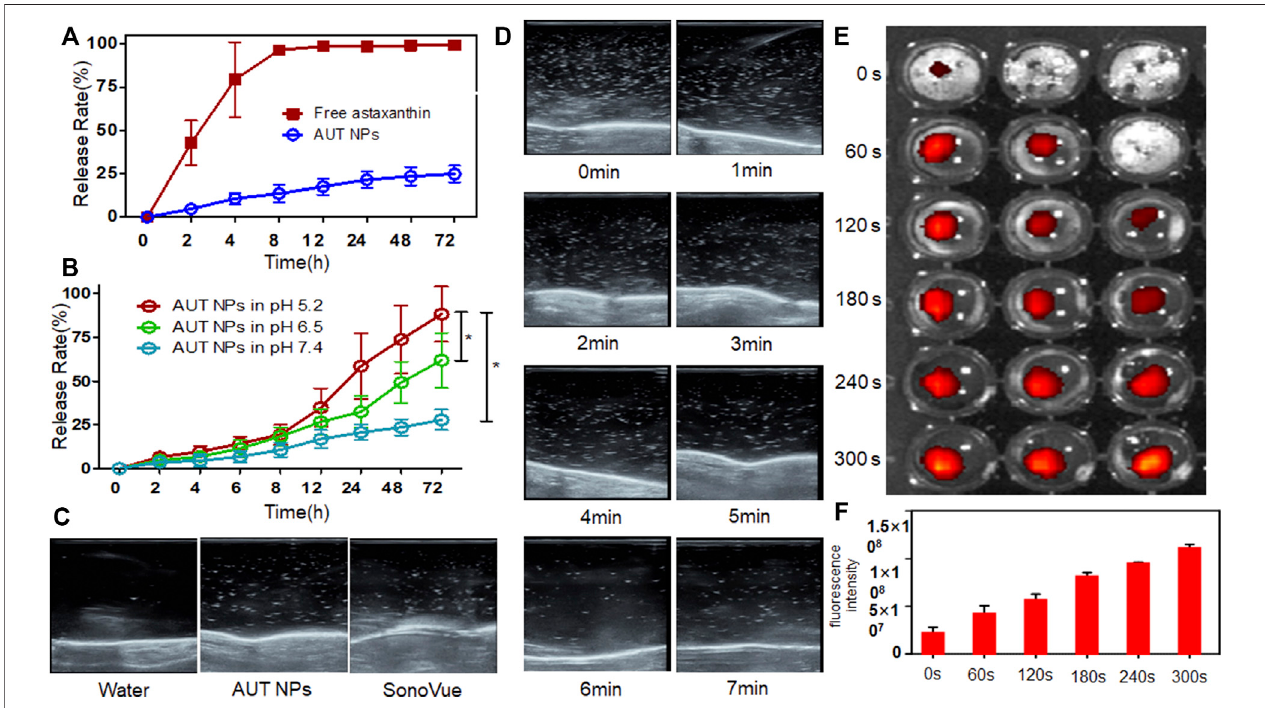
FIGURE2| ThedrugreleaseofAUTNPsundernormal (A) andpHstimulus (B) .TheUStriggeringimageswithdifferentcontrastagents (C) .Thereal-timeultrasonic images of AUT NPs at each time points (D) . The IR780 fl uorescent images under US (E) . The fl uorescent intensity changes of IR780 under a series of US triggering time lengths (F) . The* represents p < 0.05, ( n (cid:2) 3).